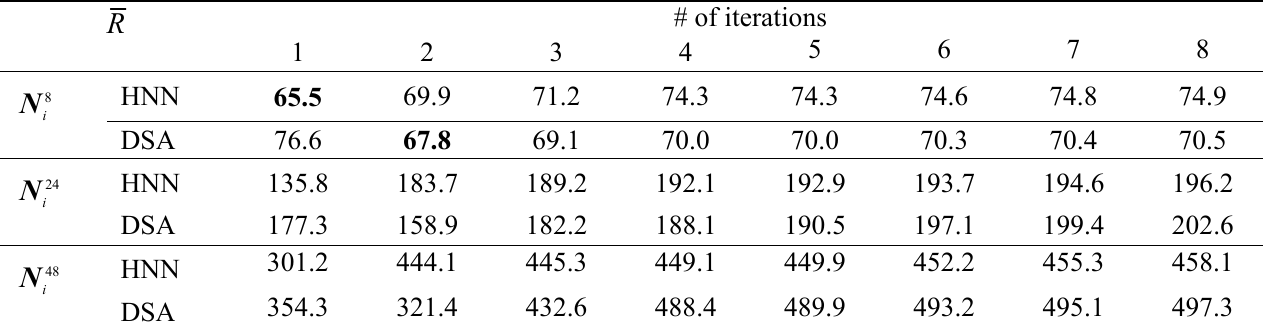
Table 2. Averaged separability values R for the HNN and Deterministic Simulated Annealing (DSA) against the number of